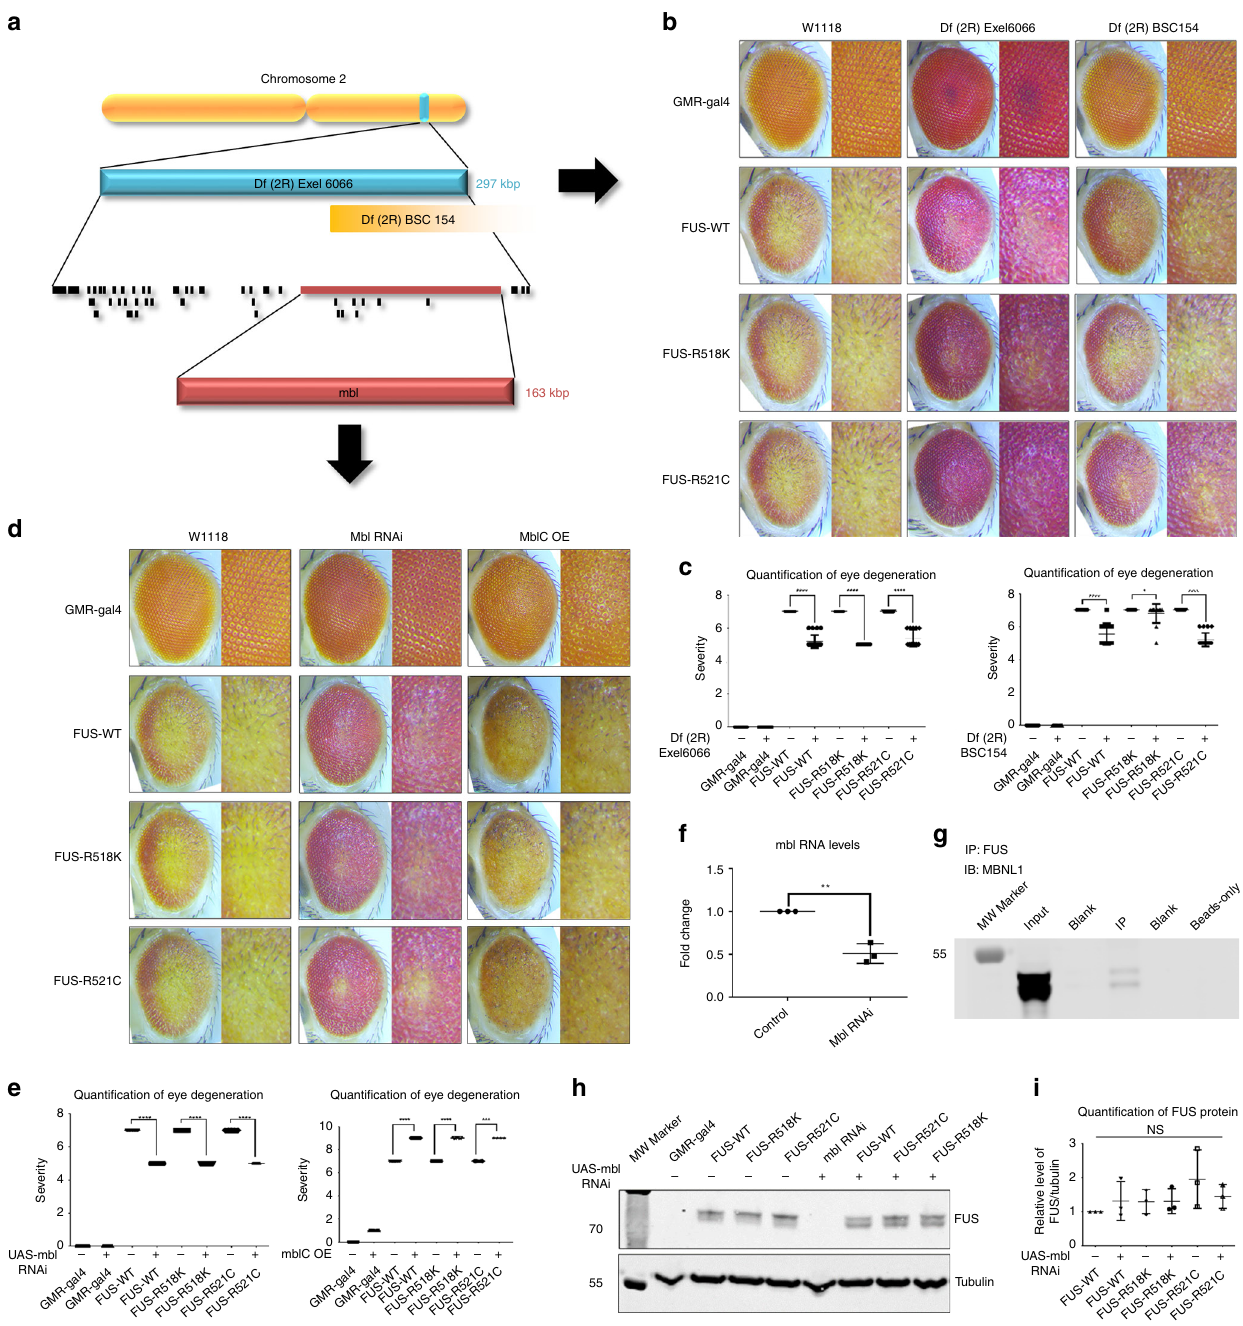
modi fi er of FUS-associated ALS. FUS lines with known site- speci fi c integration (SSI) of the transgenes were used to further validate whether reducing mbl RNA levels would suppress FUS toxicity. Wild-type FUS and the two ALS-linked mutant FUS- R518K and FUS-R521C lines with known SSI of the transgenes were crossed with mbl RNAi lines, which were also generated using site-speci fi c integration methods. RNAi-mediated knock- down decreased mbl RNA by ~ 49% and signi fi cantly suppressed external eye degeneration in all FUS-expressing Drosophila (Fig. 1c – f). Knockdown of endogenous Mbl did not reduce FUS protein levels in the Drosophila , indicating that this effect was not due to a loss of toxic protein (Fig. 1h, i). Knocking down endogenous Mbl alone in these fl ies was well-tolerated, as it did NATURE COMMUNICATIONS| (2019) 10:5583